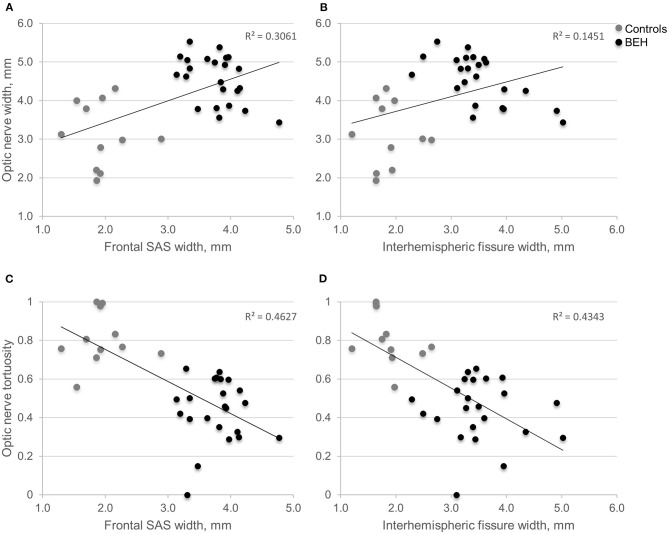
Scatter plots displaying the relationship between the extent of optic nerve width or tortuosity, and mean volume of CSF spaces. (A,B) As the interhemispheric fissure or frontal SAS enlarges, the optic nerve widens. (C,D) As the interhemispheric fissure or frontal SAS enlarges, optic nerve tortuosity declines. BEH, benign external hydrocephalus (diagnosed by neuroradiologist); CSF, cerebrospinal fluid; SAS, subarachnoid space.